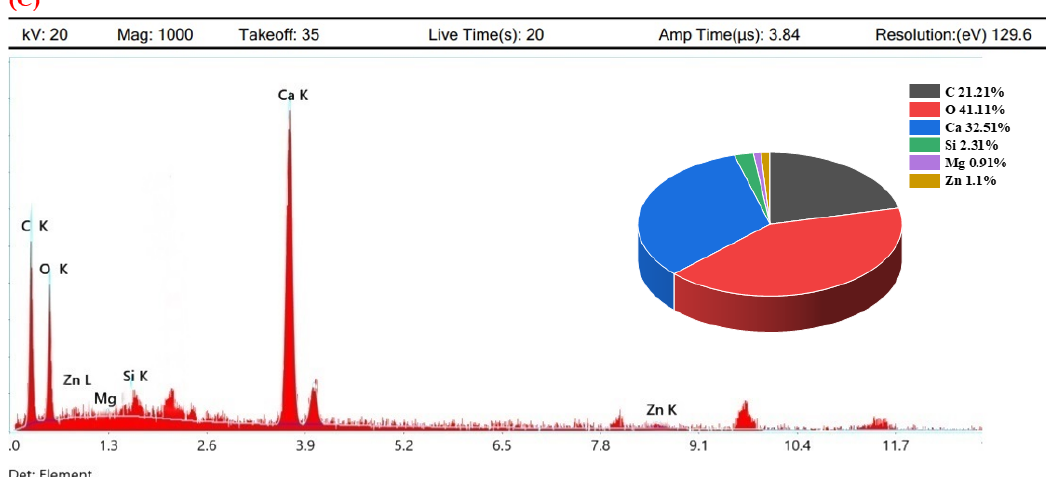
Figure 17. ( A ) Healed area under optical microscope, ( B ) SEM of healing product, ( C ) Spot-EDS of healing product.